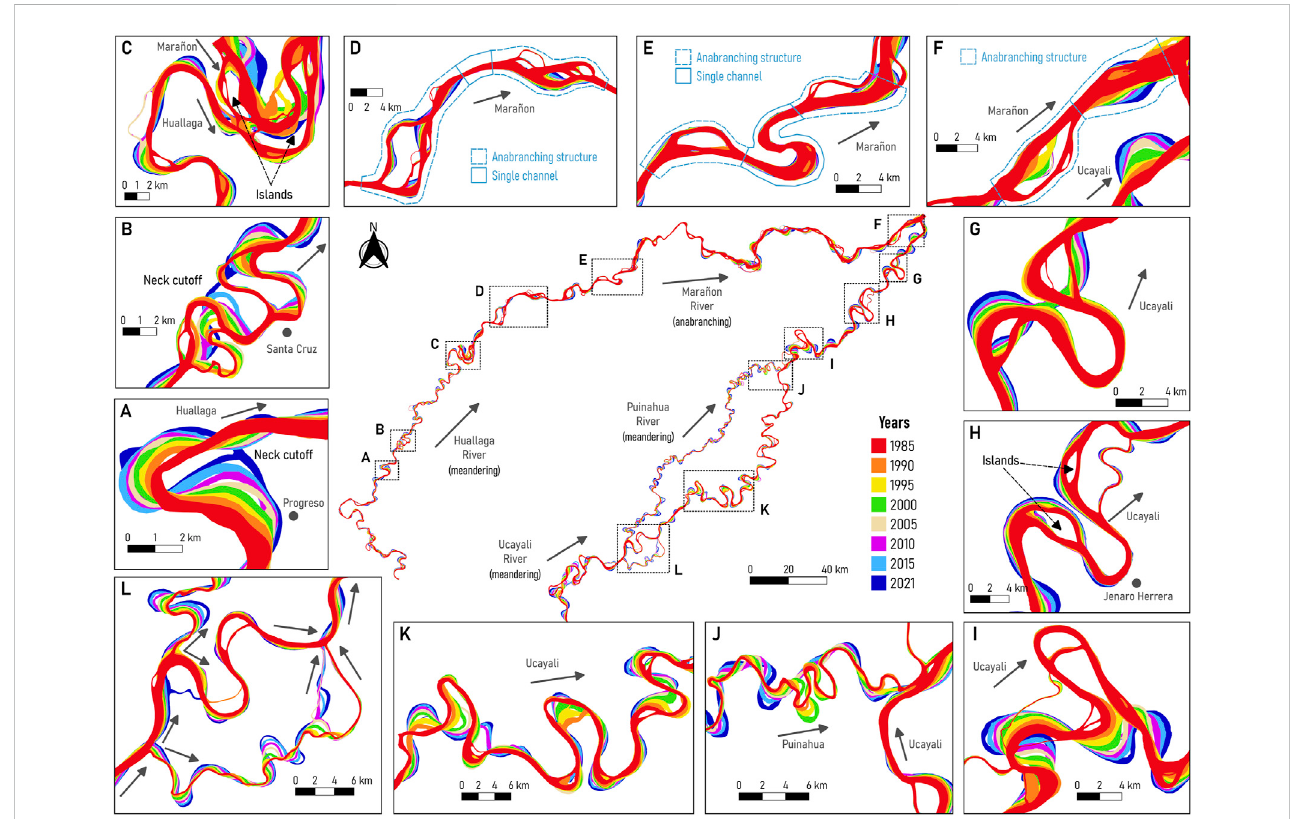
FIGURE 3 ModernRiverdynamics(from1985to2021)intheP-Swetland. (A) ]HuallagaRiver(nearProgreso), (B) HuallagaRiver(nearSantaCruz), (C) Con fl uenceof the Huallaga and Marañon Rivers, (D,E) Marañon River, (F) Con fl uence of the Marañon and Ucayali Rivers, (G – I) Lower Ucayali River, (J) Con fl uence of the Ucayali and Puinahua Rivers, (K) Ucayali River, (L) Bifurcation of the Ucayali and Puinahua